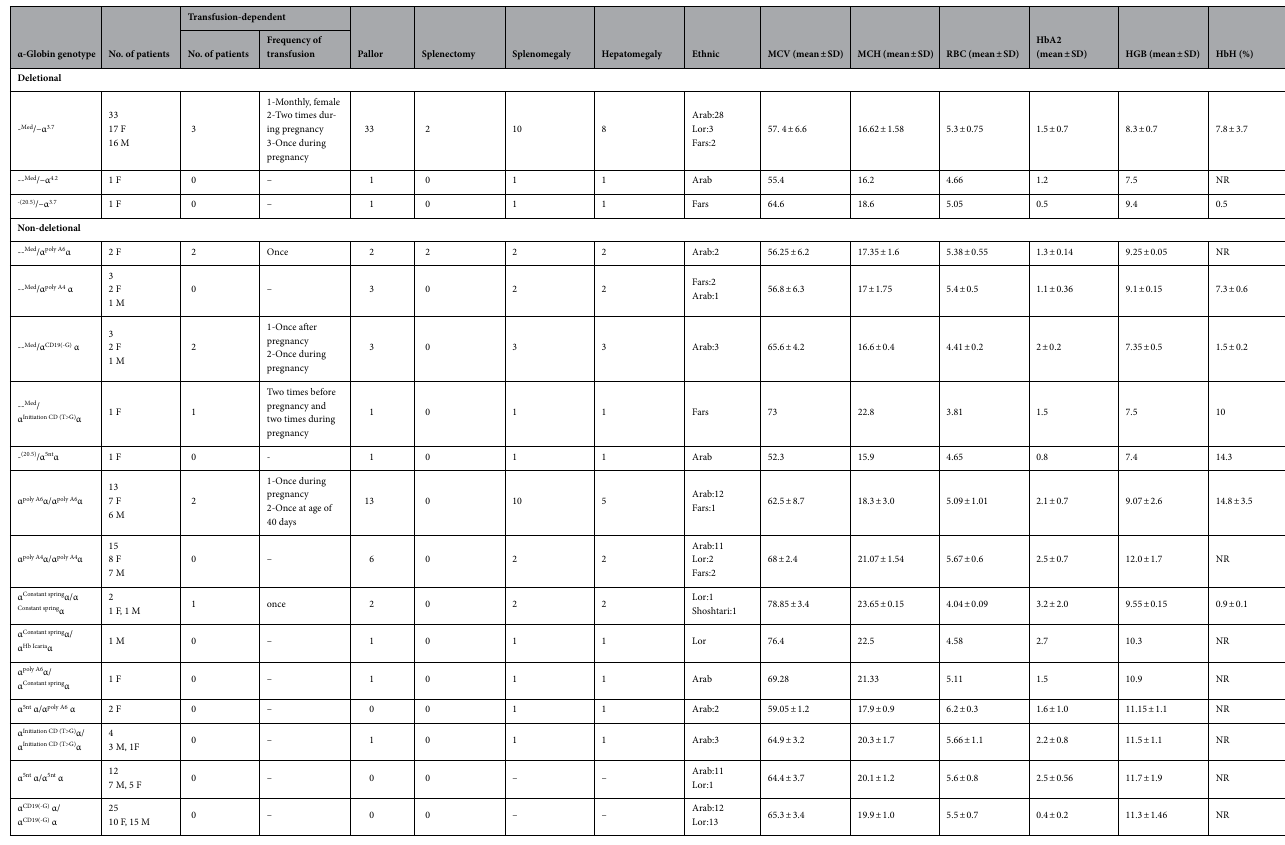
Table 1. Genotype diversity of deletional and nondeletional HbH disease, hematological indices and clinical manifestations. NR Not